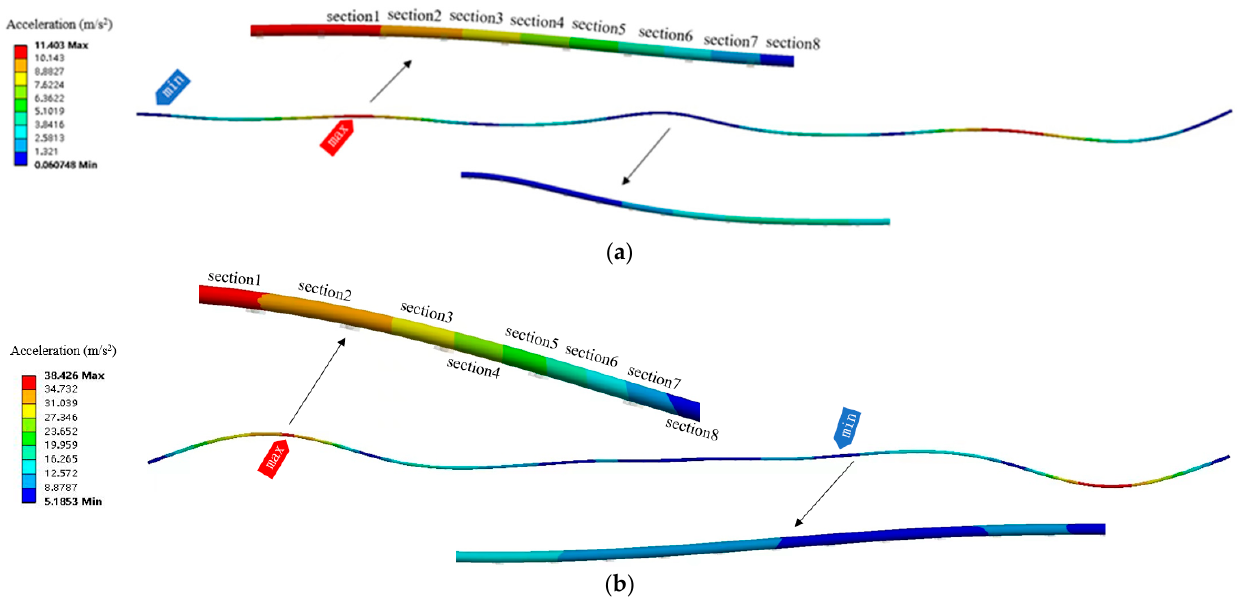
Figure 7. ( a ) The acceleration response cloud atlas of the pipeline model with the fluid – structure coupling effect; ( b ) the acceleration response cloud atlas of the pipeline model with the additional- mass method.